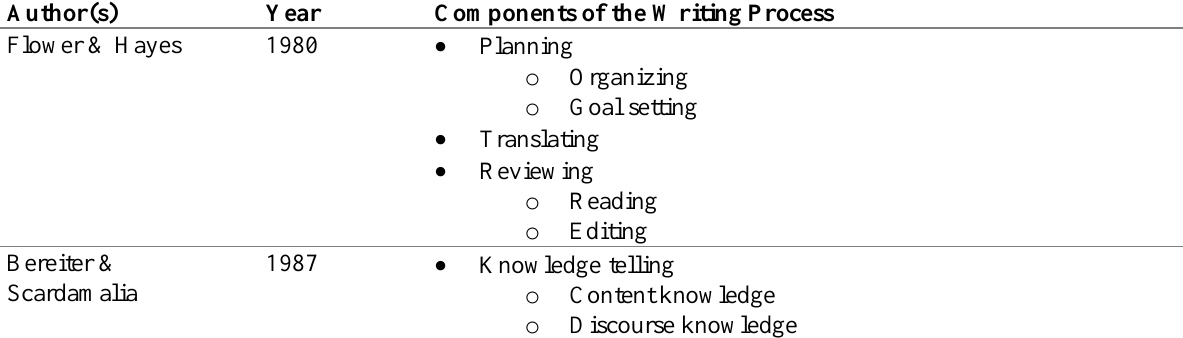
Summary of the Early Theoretical Frameworks of Writing